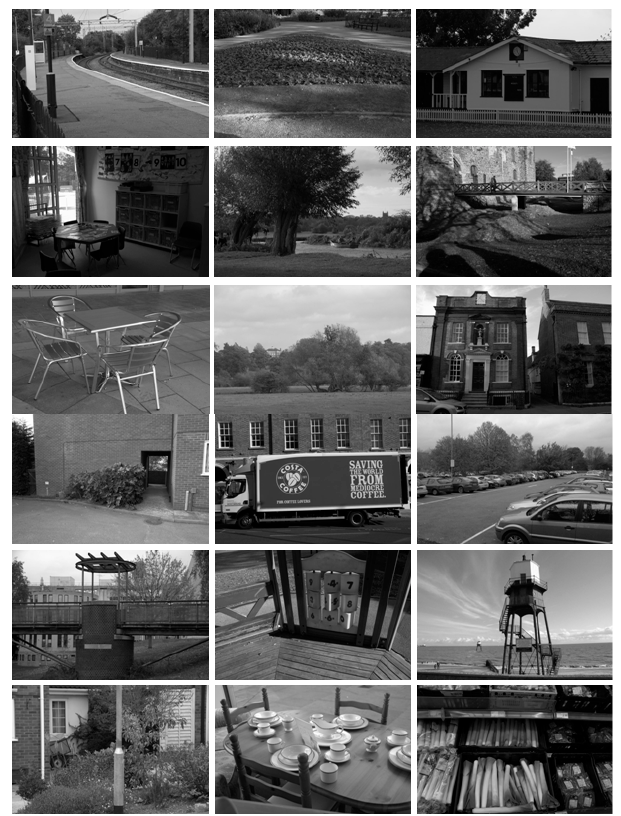
Figure 2. Some sample scenes from the image database.